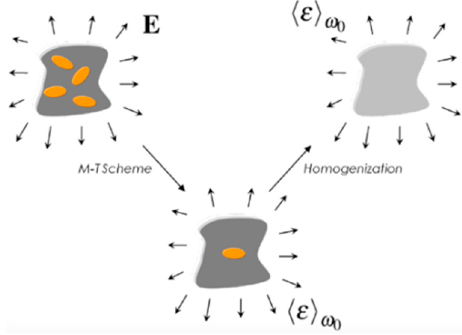
Figure 3. Representation of the Mori-Tanaka (M-T) analytical approach.